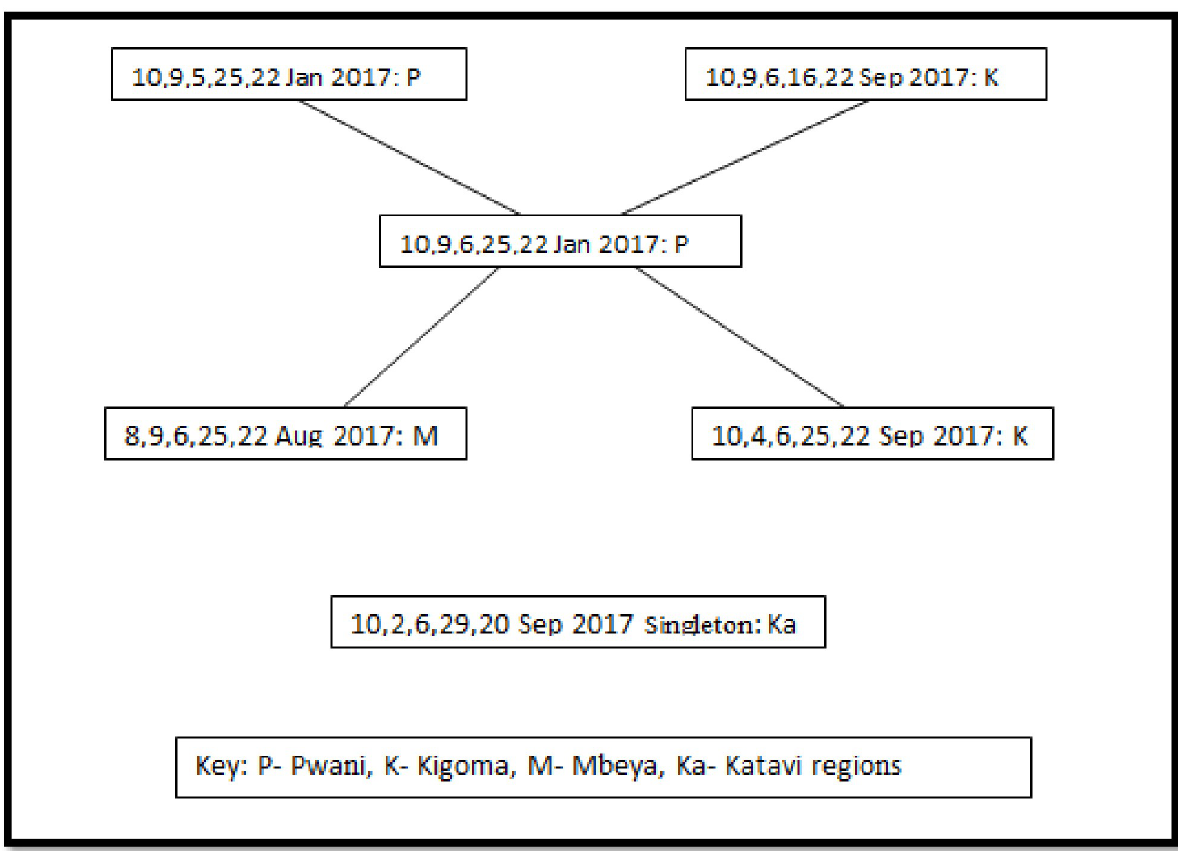
Fig 3. Genetic relatedness between V . cholerae genotypes in CC2 and one singleton genotype by MLVA, time, and regions. Five numbers represent genotype; each connecting line shows an allelic change at a single locus of a genotype. CC2 represents five genotypes. One singleton genotype that differed at two or more loci to the other genotypes was considered genetically unrelated.